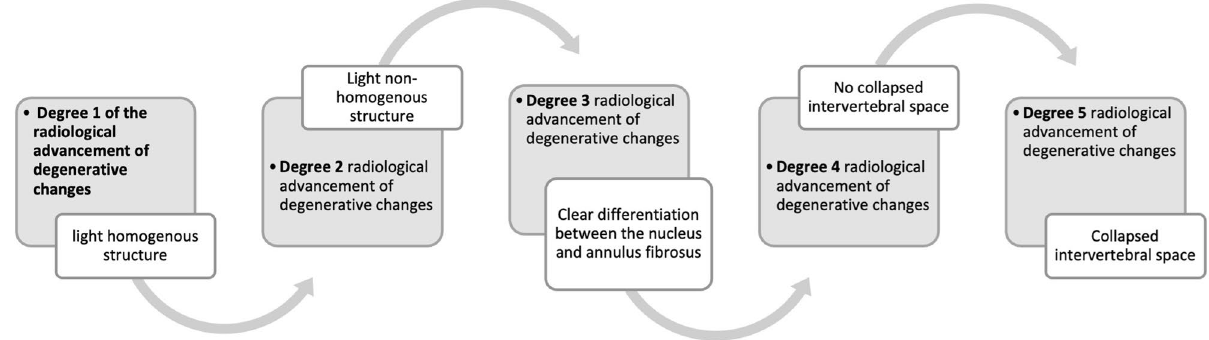
Figure 3. Protocol for the assessment of the radiological advancement of degenerative changes in human IVDs using the Pfirrmann scale [own